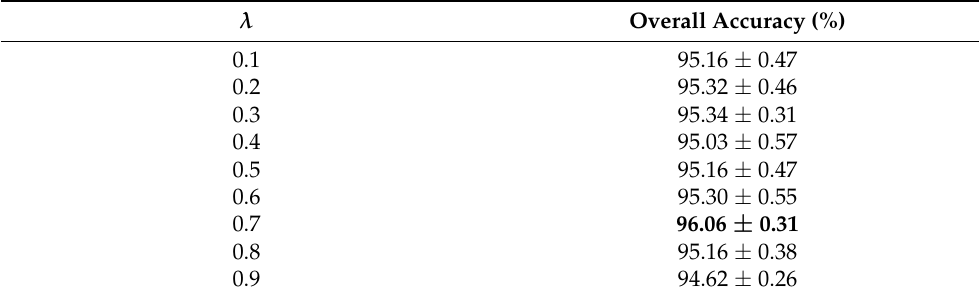
Table 2. Overall accuracy on the OPTIMAL-31 dataset with different balance parameters of the joint loss by